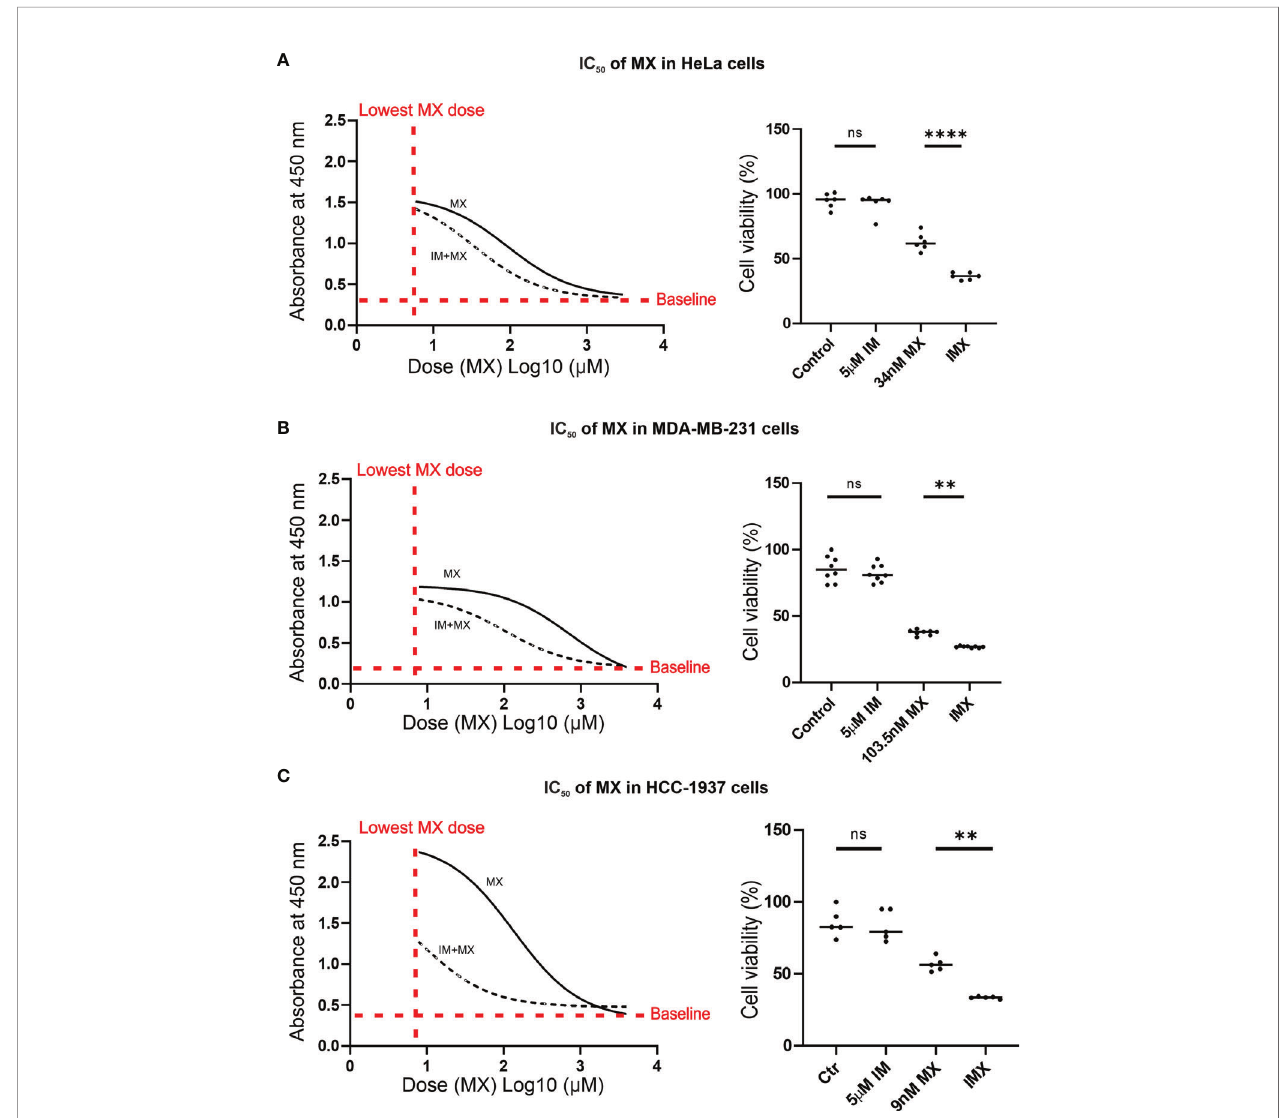
FIGURE 3 | IM reduces IC50 of MX in cancer cells. In A – C, the non-linear plots show dose vs . response curves where X-axis presents dose (MX) Log10 (µM) and Y-axis represents absorbance at 450 nm, which is proportional to the amount of viable cells (p < 0.05). The column scatter plots represent median cell viability (%), where the effect of MX combined with 5 µM IM (IMX) is compared to 0.1% DMSO (control), 5 µM IM, and MX (ordinary one-way ANOVA: p < 0.05). (A) In HeLa cells, IC 50 of MX was 92.5 nM (95% con fi dence interval (CI): 63 – 136.5), and IC 50 of MX combined with 5 µM IM (IMX) was 34 nM (95% CI: 25 – 46). (B) In MDA-MB-231 cells,